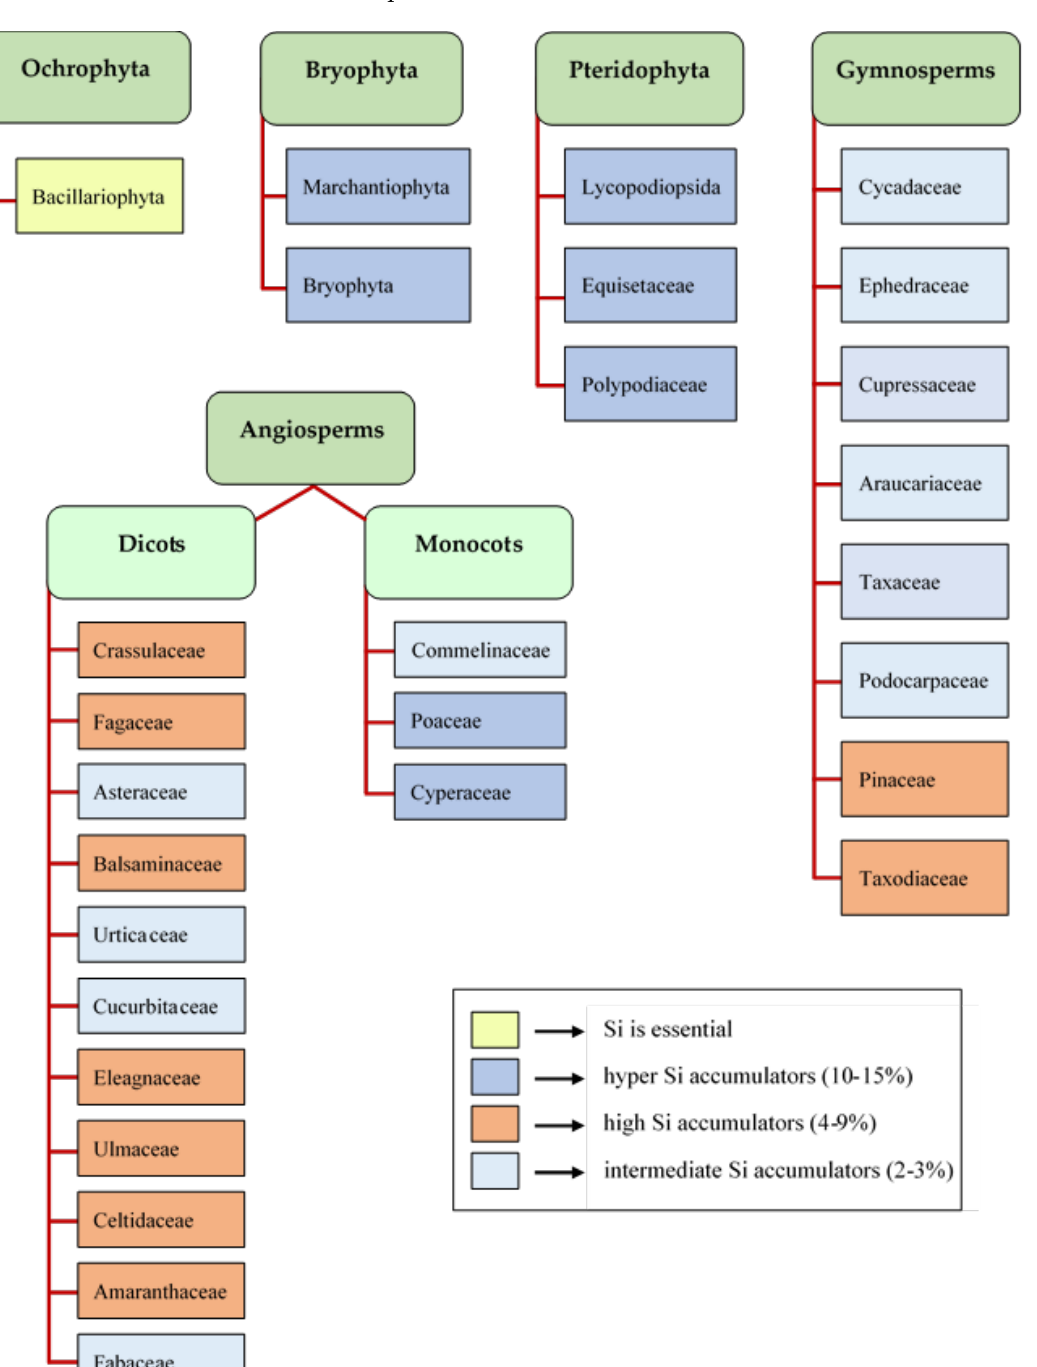
Figure 1. Distribution of different levels of Si accumulation in the plant kingdom [2,17 –